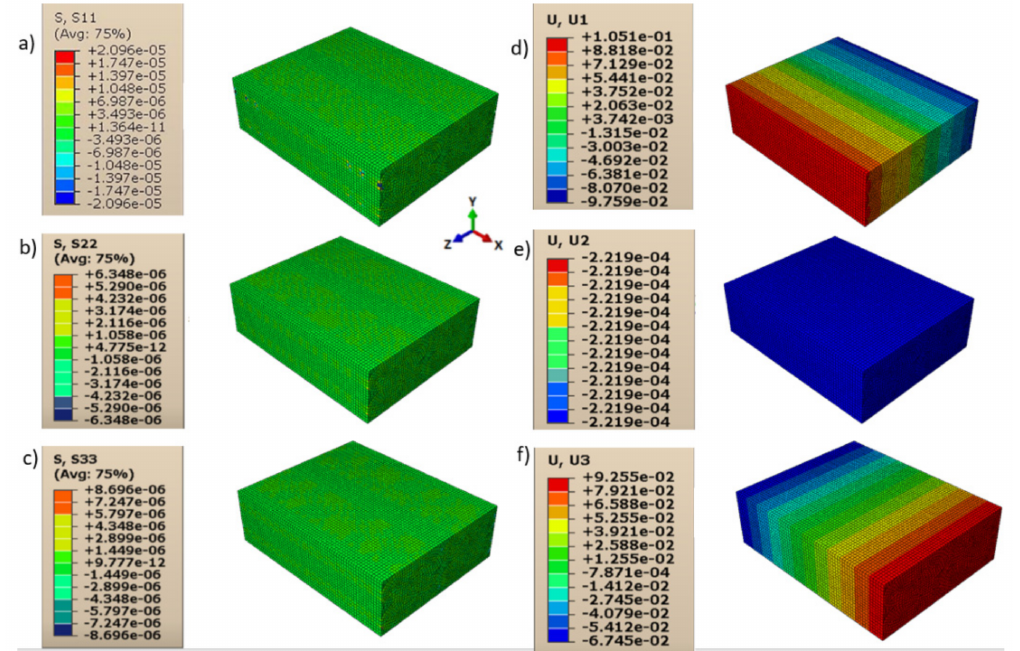
Figure 14. Load cases to evaluate G 13 : ( a ) stress in direction 11; ( b ) stress in direction 22; ( c ) stress in direction 33; ( d ) displacement in direction 11; ( e ) displacement in direction 22; ( f ) displacement in direction